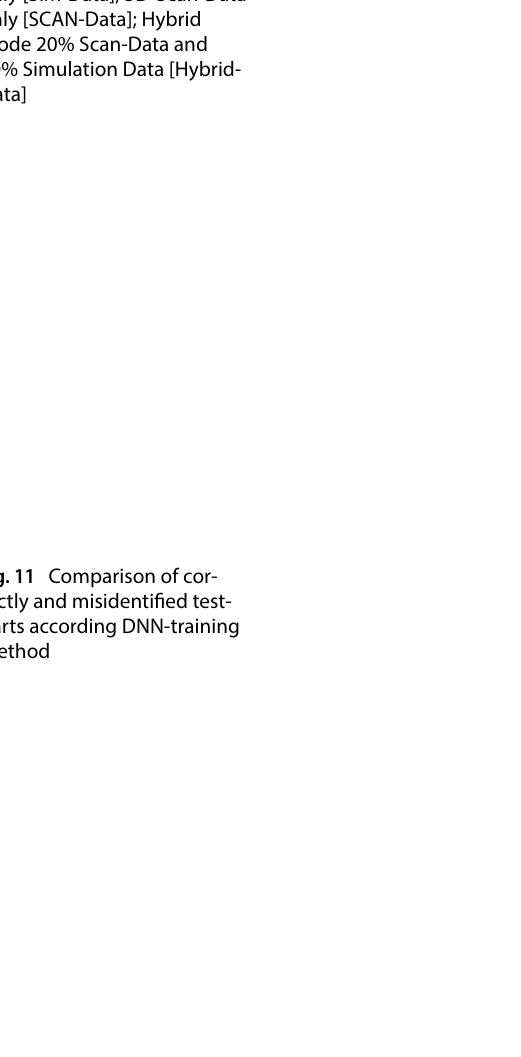
Fig. 10 DNN part-detection confidential score. Training procedure: Simulation Data only [SIM-Data]; 3D-Scan-Data only [SCAN-Data]; Hybrid mode 20% Scan-Data and 80% Simulation Data [Hybrid- Data]